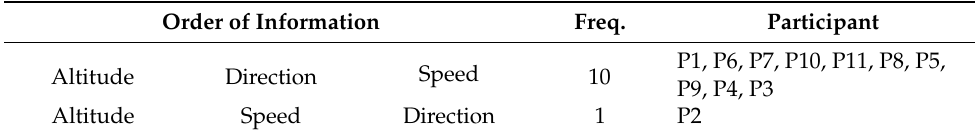
Table 5. Order of information